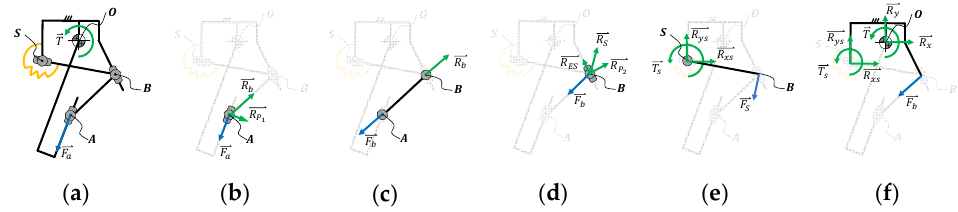
Figure 3. The torque ratio (torque at the output (T) divided by the force at the input (F a )) of the torsional implementation is found by performing a free-body diagram analysis of the proposed mechanism ( a ), including the input slider joint ( b ), the connecting bar ( c ), the tuning joint ( d ), the passively actuated joint ( e ), and the output joint ( f ).